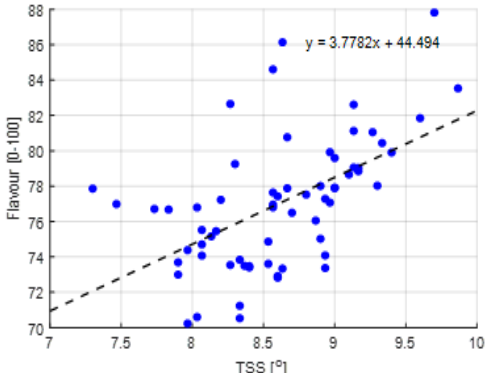
Figure 13. Correlation between TSS of tomato fruits ( o ) and fruit flavor (0 = dislike, 100 = like)) of the different greenhouse compartments (301–306).